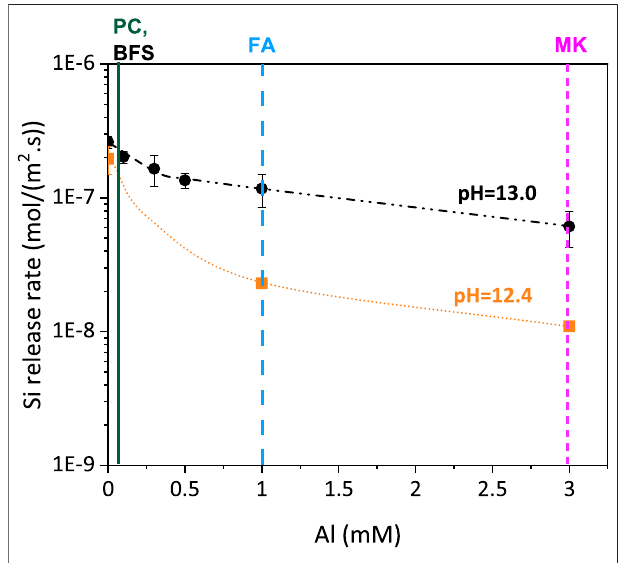
FIGURE 3 | Effect Al concentration on the Si release rate [mol/(m 2 · s)] of amorphous silica in 100 and 400 mM KOH at 40 ° C, adapted from (Bagheri et al., 2022). The vertical lines indicate Al concentrations typically observed in the pore solution of Portland cements ( ≈ 0.1 mM), in blends with blast furnace slags ( ≈ 0.1 mM), with fl y ash ( ≈ 1 mM) and with metakaolin ( ≈ 3 mM) (Deschner et al., 2012; Vollpracht et al., 2016; Avet and Scrivener,